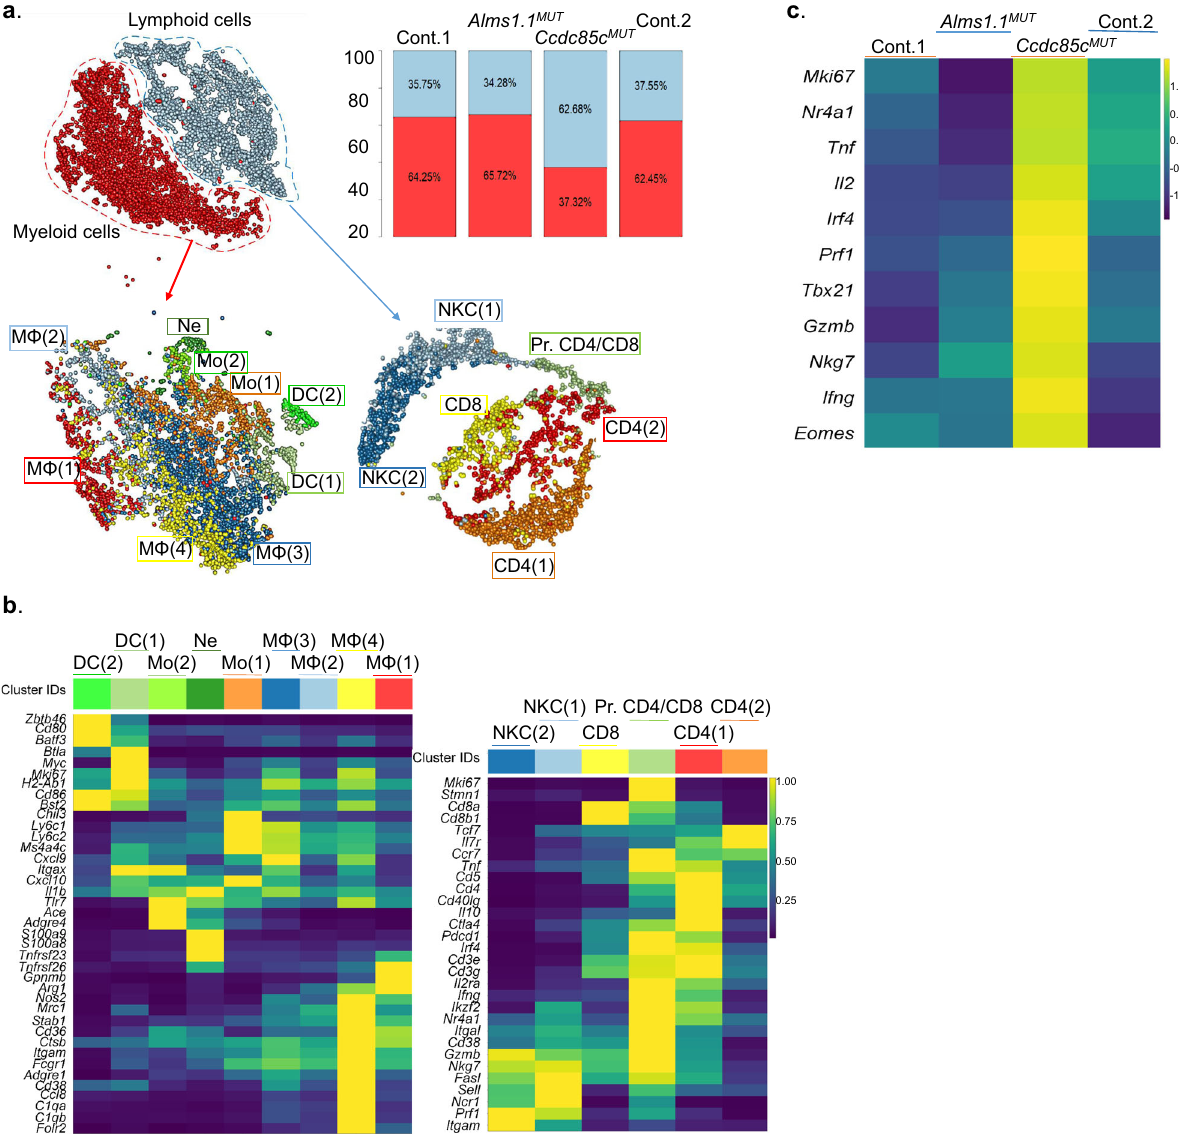
Fig. 2 Immune response in mice immunized with Ccdc85c MUT and control neoepitope Alms1.1 MUT . a Tumors from mice immunized with Ccdc85c MUT or Alms1.1 MUT as well as two groups of control mice immunized with BMDCs were harvested 10 days after tumor challenge. Tumor in fi ltrating CD45 + cells were sorted and analyzed by scRNA seq as described in Methods and Supplementary Fig 9b. Combined scRNA seq data from four libraries were analyzed. The t-SNE 34 plots of all intra-tumoral immune cells as well as myeloid and lymphoid compartments are shown in the top left panel. Myeloid and lymphoid composition for each library is shown on the right panel. The myeloid and lymphoid sub-clusters are shown in the bottom panels. See text for de fi nition of each sub-cluster. b Heat maps of the indicated genes in the myeloid and lymphoid compartments are shown. The heat map genes were selected from the list of differentially expressed genes, genes with a high average TF-IDF score, and typical cell type markers. The average gene expression for each cluster was normalized by dividing it from the maximum value of each row (gene). c Summary heat map of selected genes associated with cytotoxicity for pooled activated T cells is shown. The heat map illustrates scaled (Z-scored) average gene expression by Supplementary Fig. 6; this line with the WT sequence of Ccdc85c analyzed by scRNA seq. RNA from CD45 + cells (estimated is referred to as a Revertant (REV). As shown in Supplementary 11,961 cells for the three libraries before QC and 10,265 after QC, Fig. 6b, the REV tumor grows signi fi cantly faster than the original and with an average coverage of 61,371 reads per cell and median MUT1 line. The point mutation in Ccdc85c MUT was then re- of 2,137genes per cell) was sequenced. Data from three libraries introduced into the Revertant to generate the line MUT2 which were pooled and expression of the top average TF-IDF scoring recapitulates the original mutation as in Ccdc85c MUT . Thus, genes was compared between the three libraries (Fig. 3a). CD8 MUT1 and MUT2 are identical tumors (except that MUT1 is T cells of all three libraries showed CD8 activation markers heterozygous for the mutation while MUT2 is homozygous for it) including but not limited to: Cd69 and Cd44 as activation mar- and are different from REV only with respect to the mutation in kers, Lamp1 (CD107a) as a measure of degranulation and Tbx21 Ccdc85c MUT . Groups of mice were challenged with the three (Tbet), a transcription factor involved in transcription of tumors individually (MUT1, REV or MUT2) and their TILs cytotoxicity-associated genes (Fig. 3b, upper panel). We then